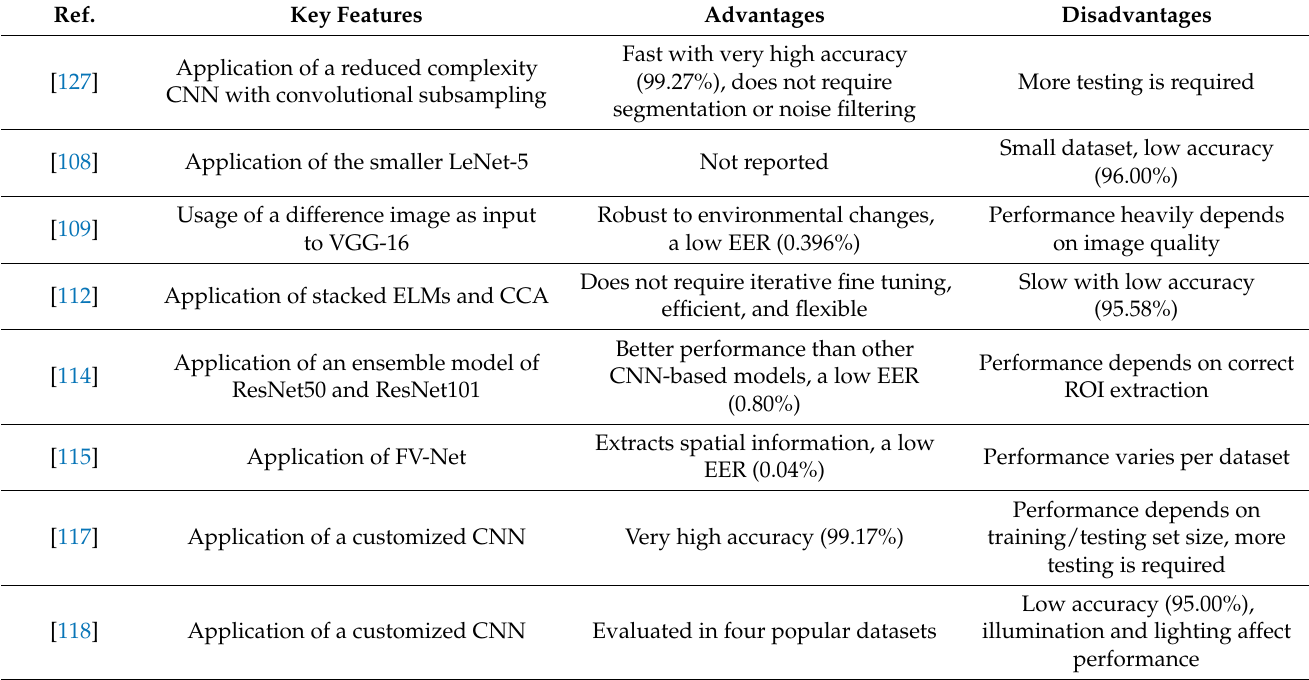
Table 6. Characteristics of the feature-learning-based